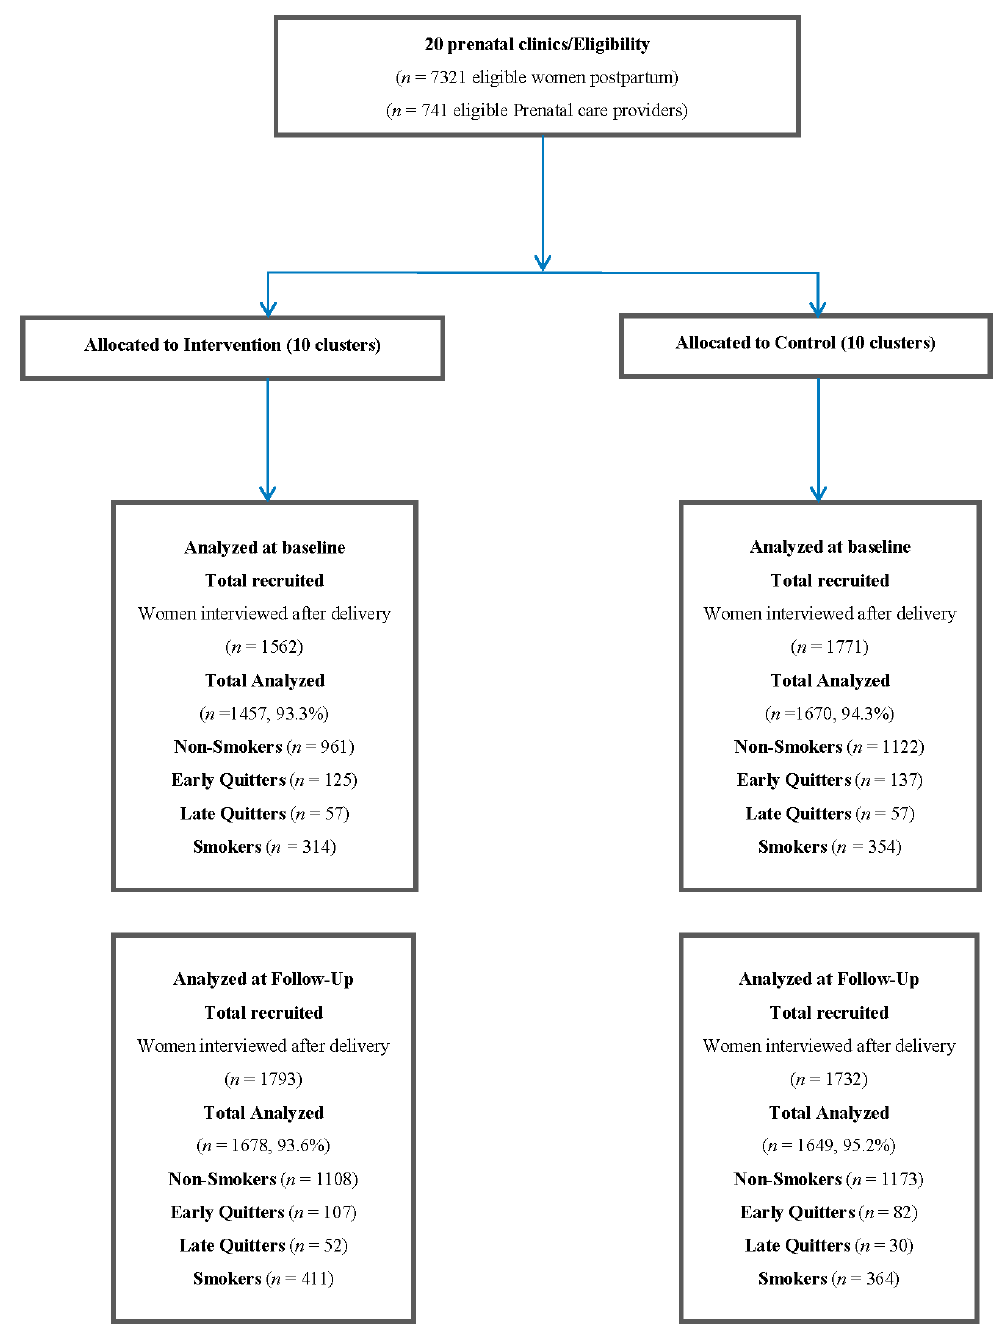
Figure 1. Trial Figure 1. Trial diagram.